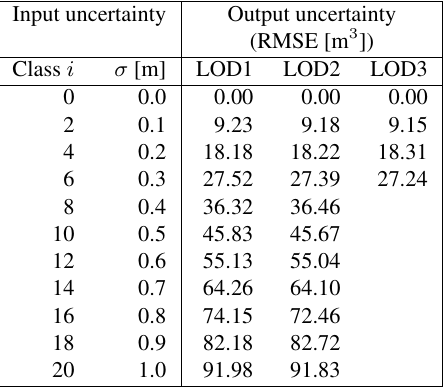
Table 1: The RMSE ( (cid:15) x,i ) for each accuracy class and LOD. The values are computed also for the ground truth models ( i = 0 ) for self-validation purposes. The simulations in LOD3 were per- formed up to and including σ = 0.3 m due to the fine LOD.